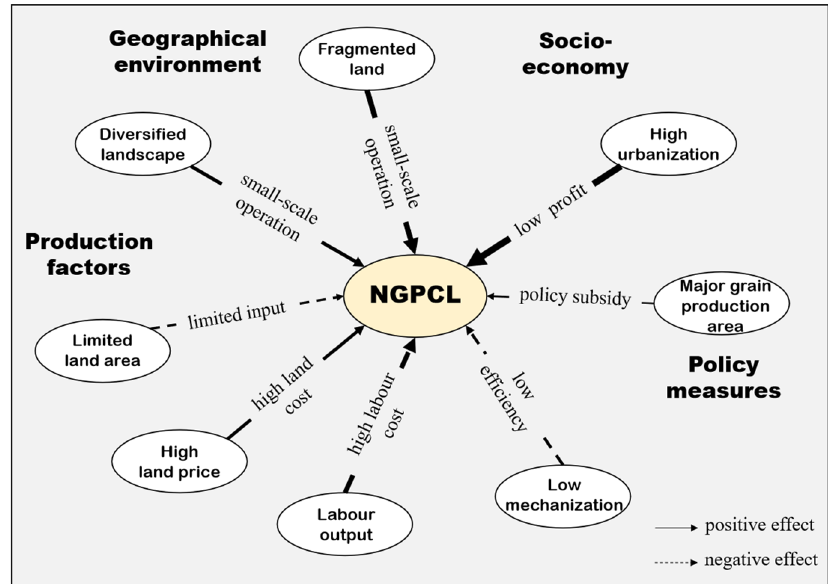
Figure 6. Mechanism of the key factors of NGPCL.